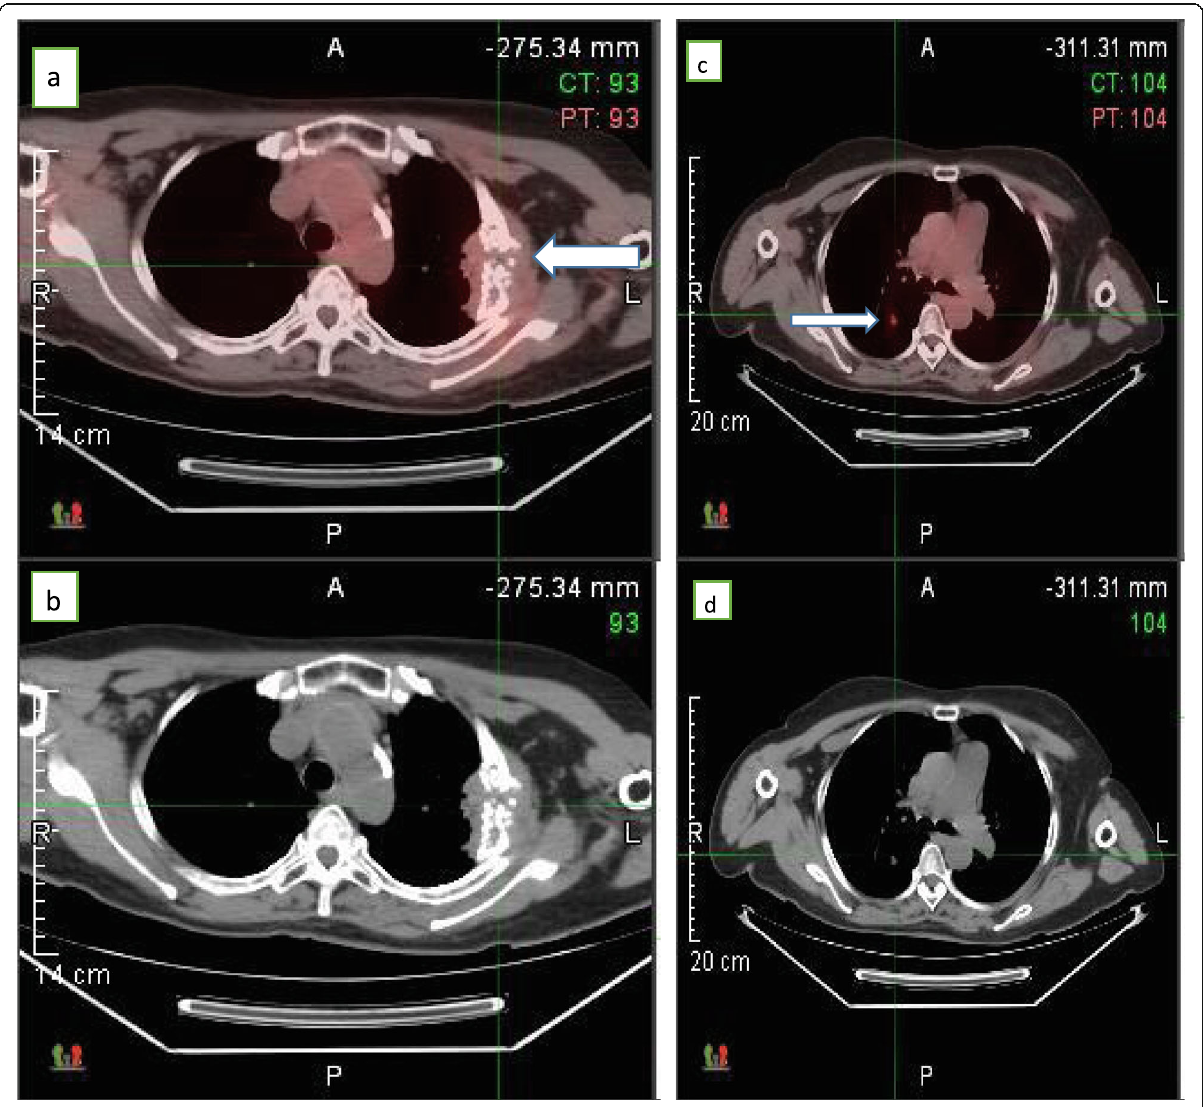
Fig. 3 ( a - d ) 65-year-old female with 2 years status post chemotherapy 18F-FDG PET/CT revealed stationary course of the left lateral upper lobe chest wall mass (7.3 cmAP×5.7 cm vertical distance ×3.5 cm wide) with coarse dystrophic calcification and underlying reconstituted rib cage. Lesion demonstrates low-grade FDG activity (SUV max 1.4) (arrow) ( a , b ). On follow-up, new 1 cm FDG avid right posterior lung nodule (SUV max 2.1) (arrow) consistent with neoplasm was detected ( c , d )